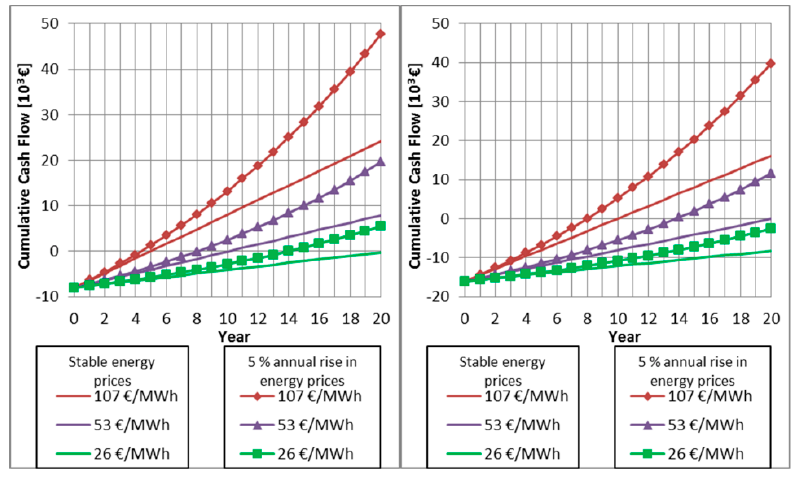
Figure 3. Return on investment for the wireless solution ( left ) and the wired solution ( right